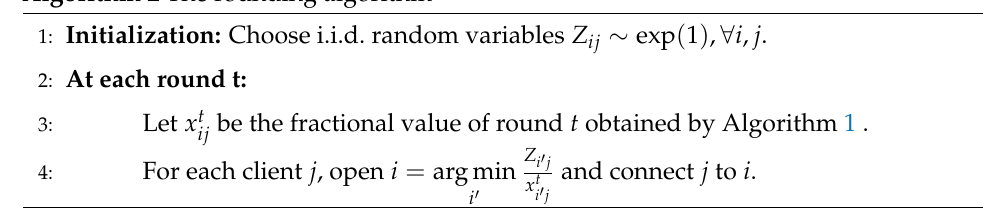
Algorithm 1 solves online a linear program to produce a fractional solution at